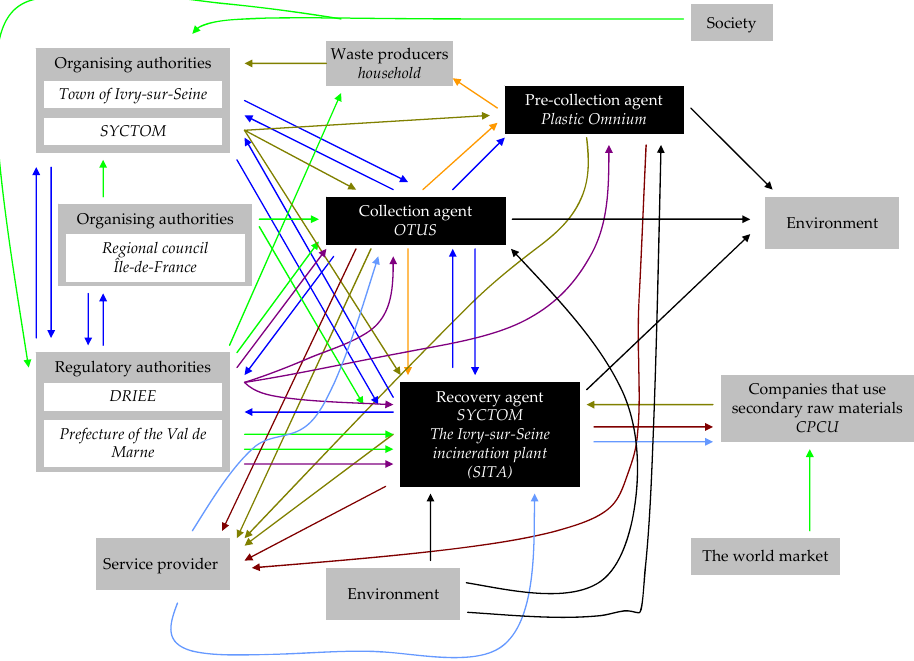
Fig. 9. The functional block diagram of the “residual household waste” Figure 9 : The functional block diagram of « Residual household waste » chain 15 16